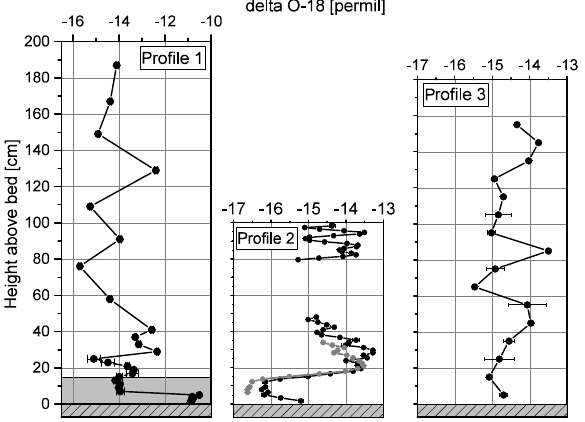
Figure 3. Stable water isotope profile of the three sampling loca- tions. Profile 2 reproduces the basal anomaly previously described by Lorrain and Haeberli (1990). The grey plot shows measurements of a neighboring block.The data gap in profile 2 corresponds to block 2-5, for which isotope measurements are not available. Note that the comparatively less negative isotope values close to bedrock in profile 1 correspond to the layers with clear ice (grey shading; see text). The basal isotope signal in profile 3 does not show outstand- ing values with respect to the rest of the profile. Error bars denote the range in values from two adjacent samples that were analyzed and the results averaged (profile 1 and 3).